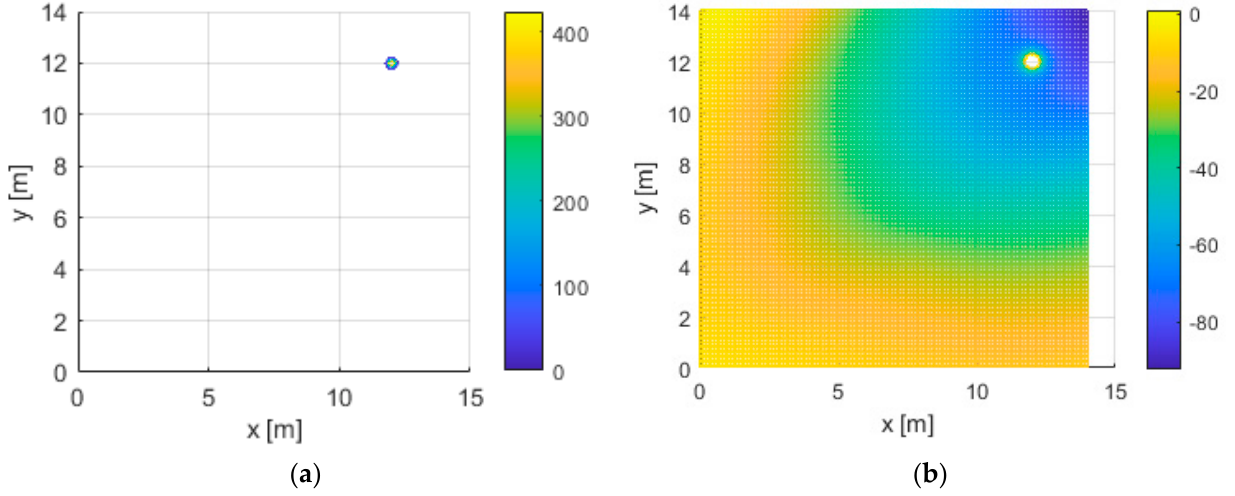
Figure 13. ( a ) Area of positive values obtained from the Lyapunov incremental function ∆𝐿 over the entire navigation surface for Agent K; ( b ) Area of negative values obtained from the Lyapunov incremental function ∆𝐿 over the entire navigation surface for Agent K.